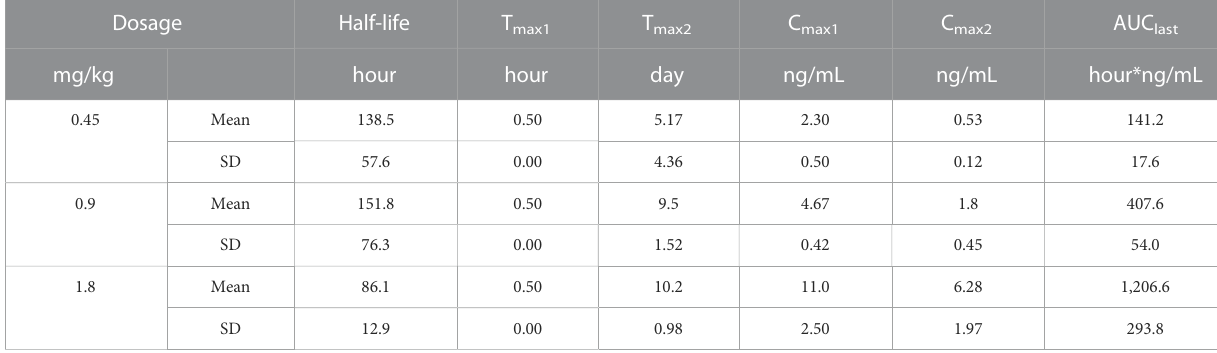
TABLE 2 Mean pharmacokinetic parameters of LY01005 in rats. Dosage mg/kg